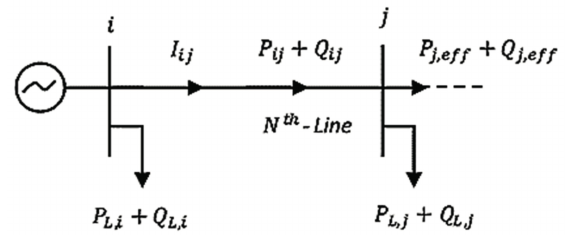
Figure 6. A sample of distribution